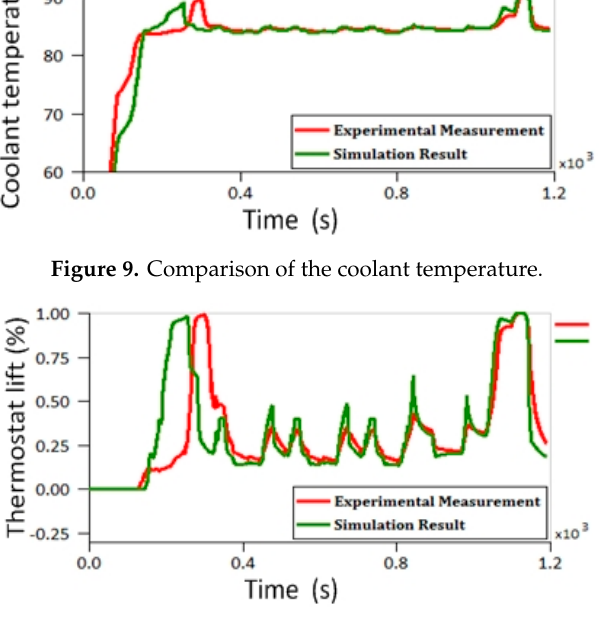
Figure 10. Comparison of the thermostat lift.